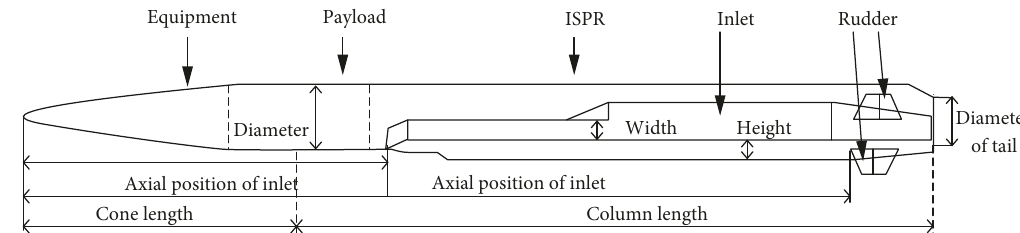
Figure 1: Typical supersonic cruise vehicle con fi